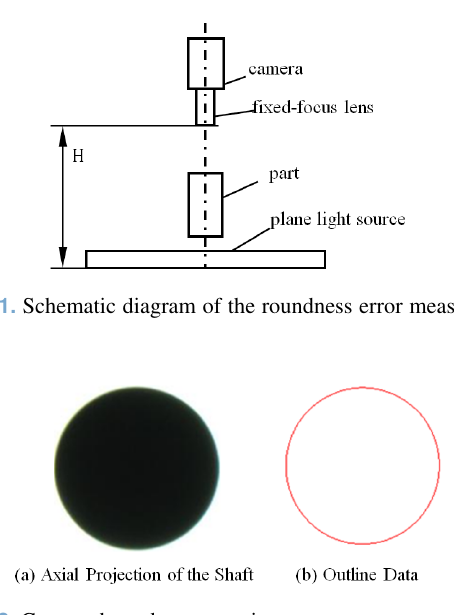
Figure 2. Contour boundary